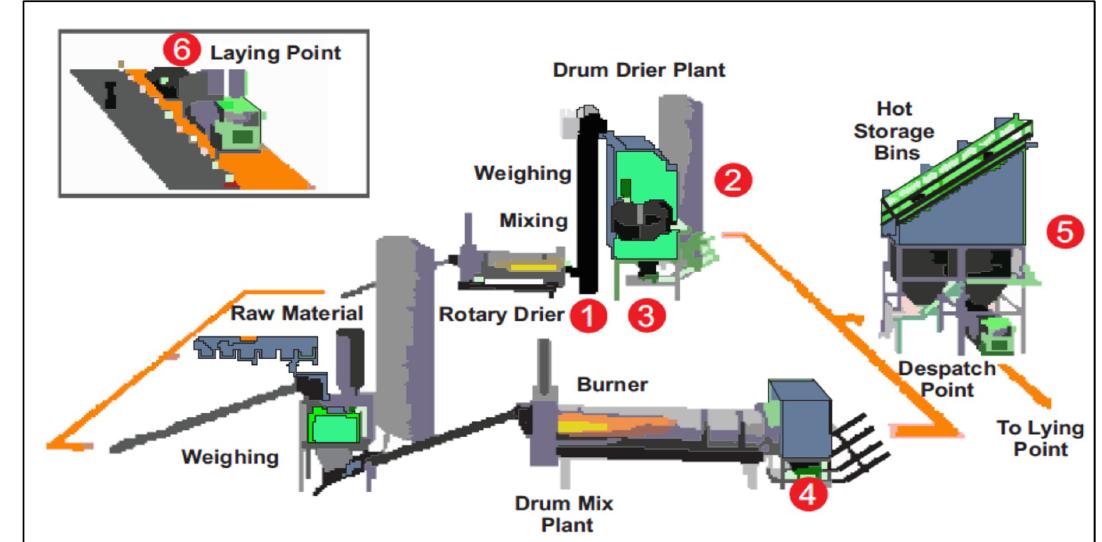
Figure 2. Hot mix asphalt production and laying process for road construction .